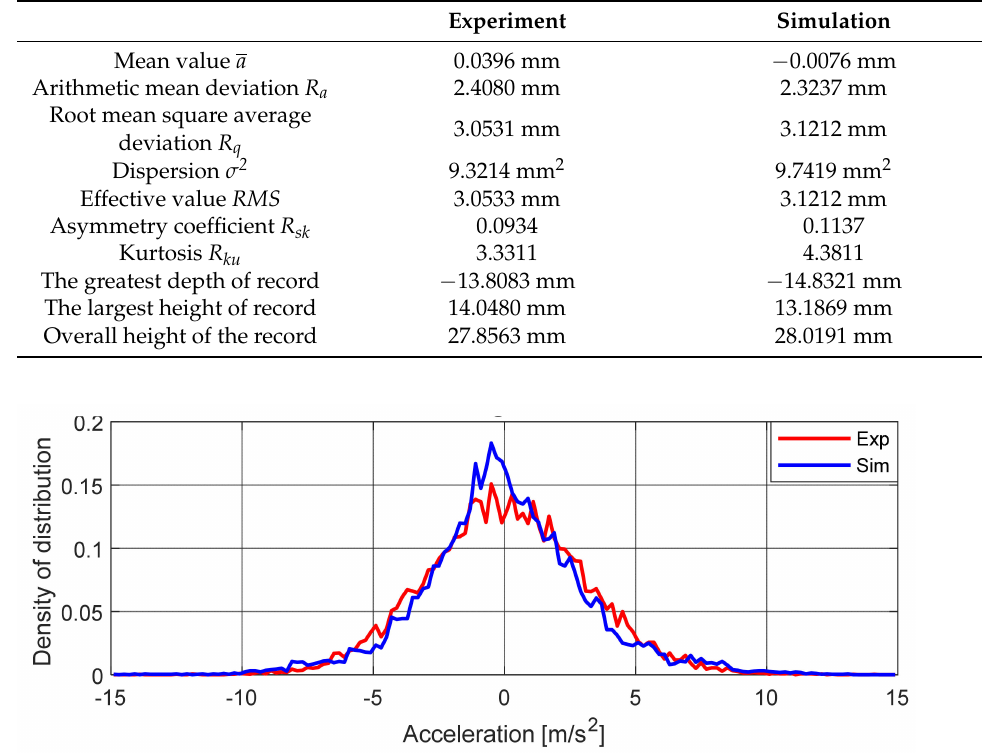
Figure 33. Density of probability distribution, acceleration on vehicle